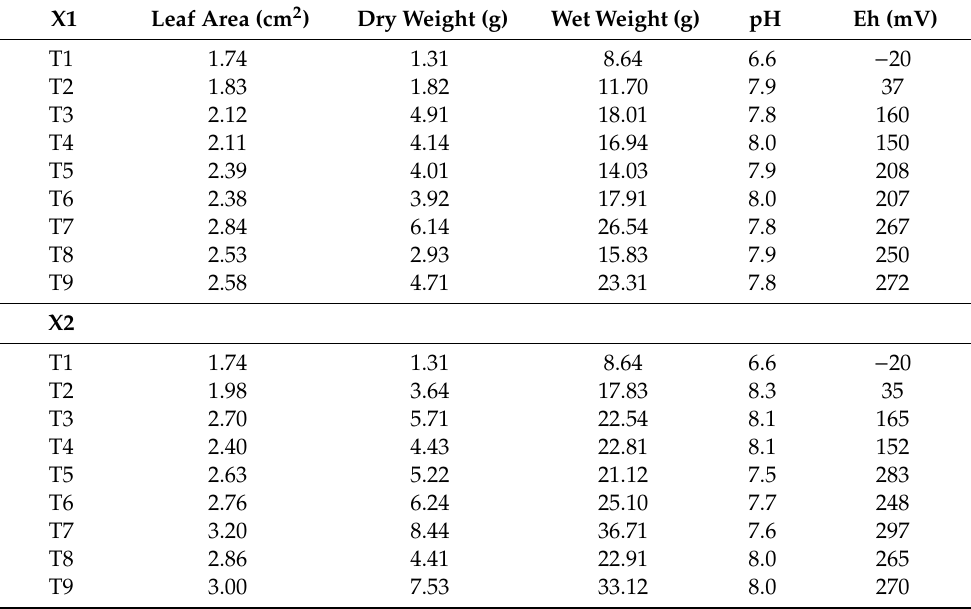
Table 5. Mean values of plant leaf area, dry weight, wet weight, soil pH, and Eh. X1 Leaf Area (cm 2 ) Dry Weight